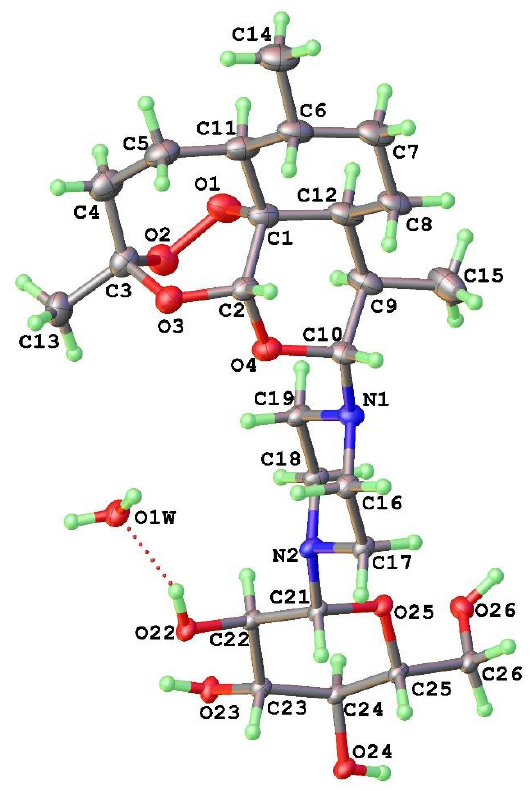
Figure 5. ORTEP plot from X-ray crystallographic structural determination of the N -glucosylated DHA piperazine 18 indicating co-crystallization with water, the diaxial arrangement of H-9 and H-10, the chair piperazine and α-equatorial artemisinin C-10 to N-1 bond, and equatorial glucosyl C-21 to N 2 bond. Numbering is as for the artemisinin nucleus in Figure 1.